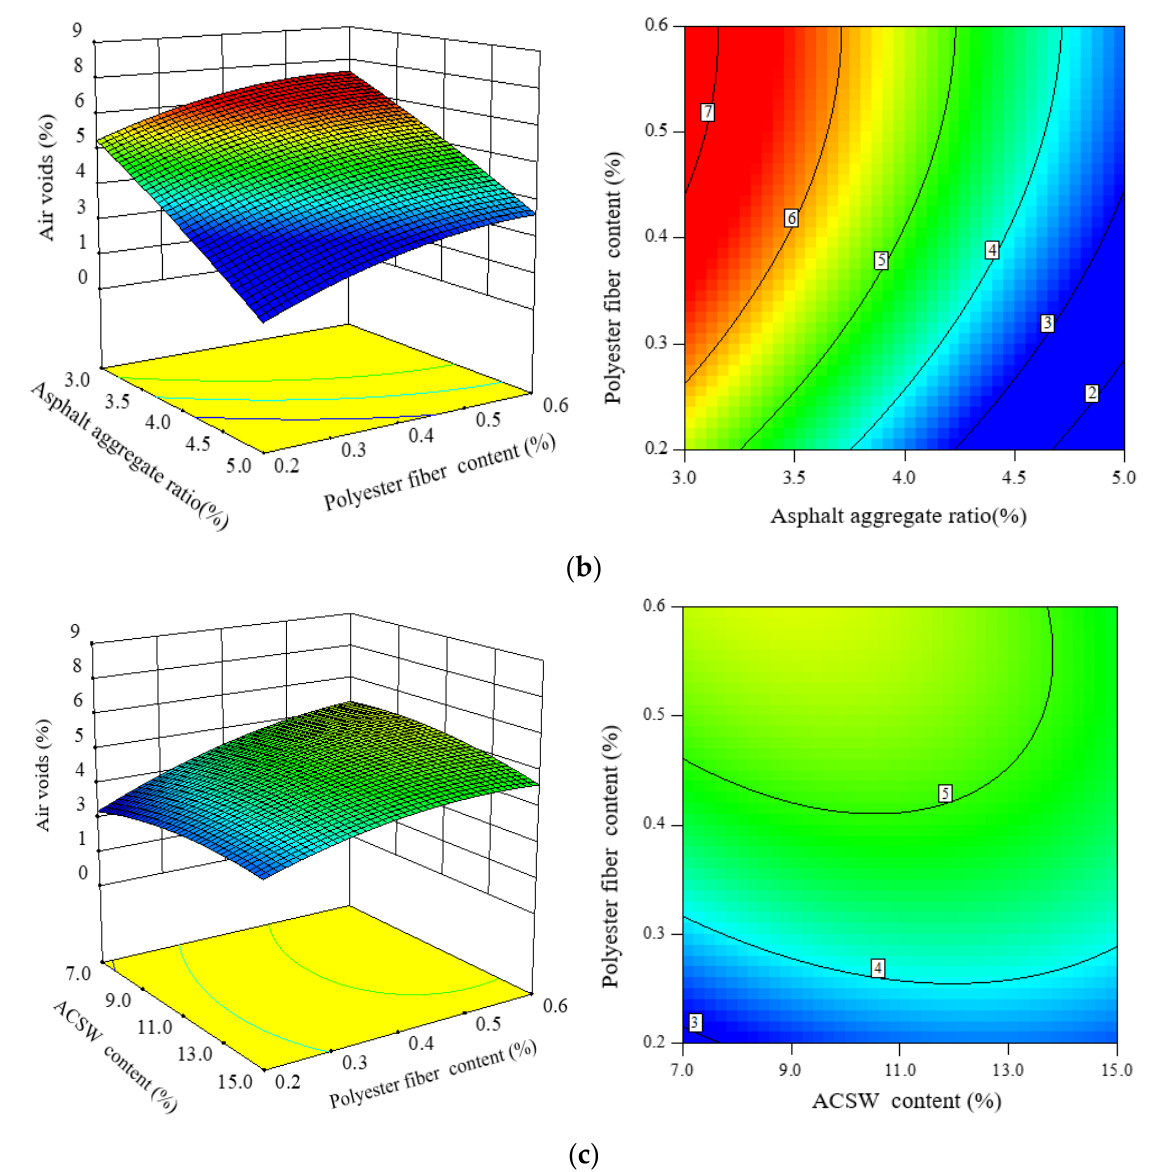
Figure 6. Three- and two-dimensional CCC response maps among three factors on AV : ( a ) factors: asphalt aggregate ratio and ACSW content; ( b ) factors: asphalt aggregate ratio and polyester fiber content; and ( c ) factors: ACSW content and polyester fiber content.